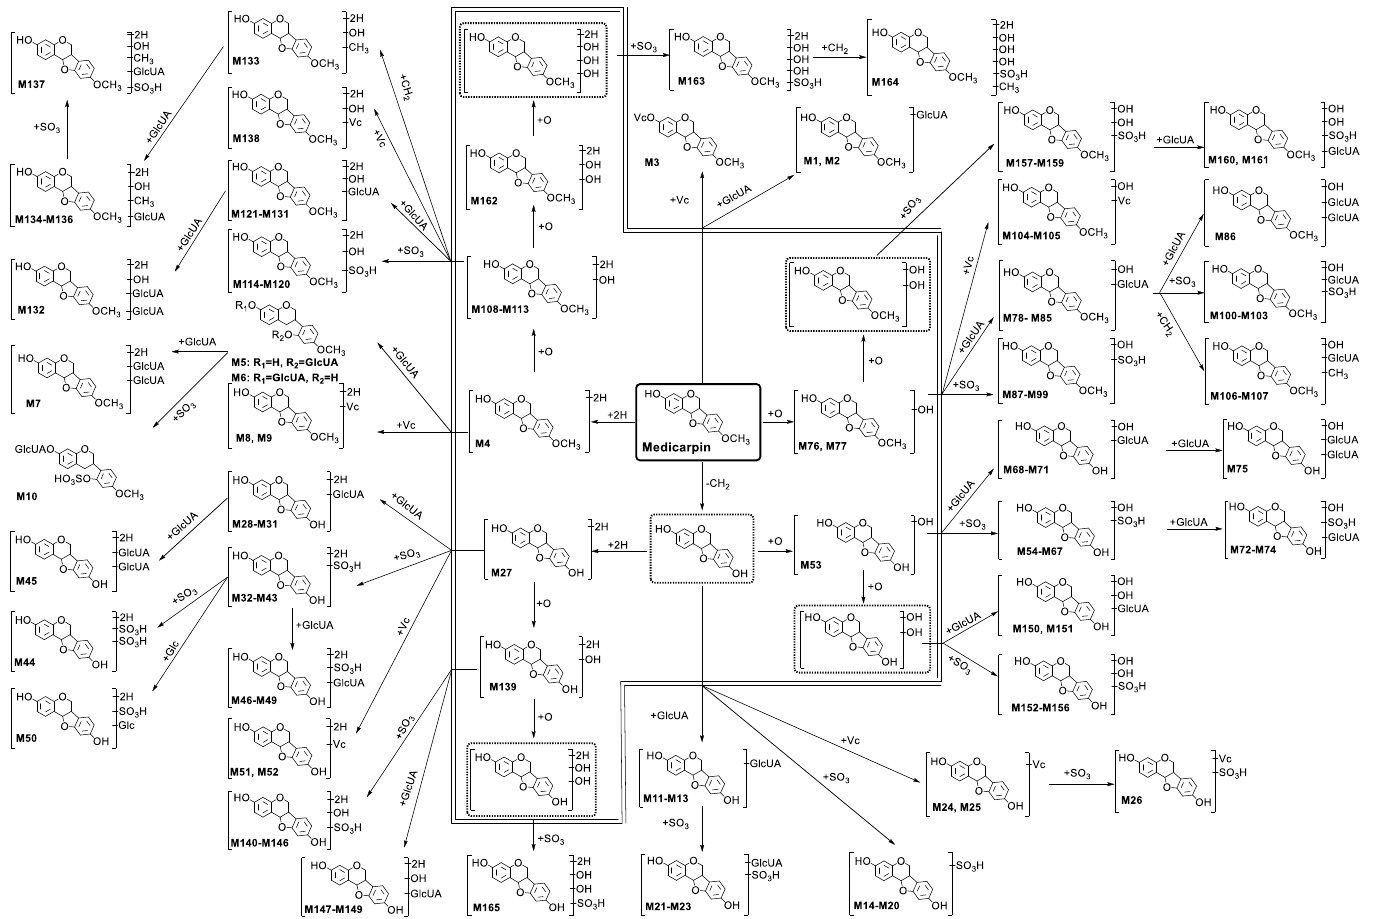
Figure 3. The proposed metabolic pathways of medicarpin in rats. Phase I metabolites are in the double line polygon, undetected intermediates are in the dashed line boxes.